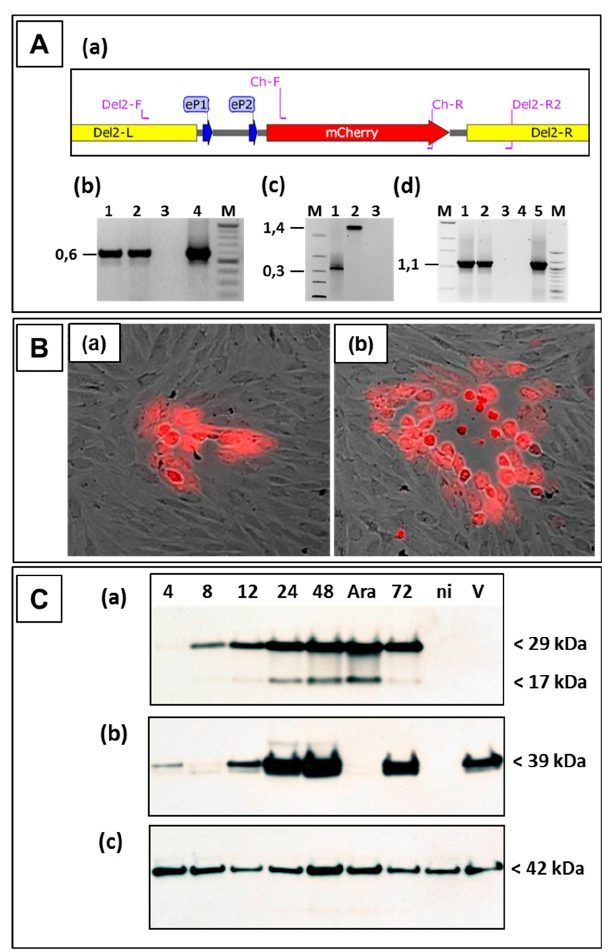
Figure 4. Legend: Characterization of the ORFV recombinant D1701-V-D12-mCherry. ( A ) PCR demonstrating correct transgene insertion. ( a ) Map section of plasmid pD12-mCherry illustrates location of the used primers also described in Table 1. The left (Del2-L) and the right (Del2-R) homology arm for recombination, early promoter eP1 and eP2 and the mCherry gene are shown. ( b ) Using primer pair Ch-FR the mCherry -specific amplicon of 0.59 kbp in size was obtained with DNA from red virus plaques (lanes 1 and 2) and with control plasmid pD12-Cherry (lane 4) but not in non-infected cells (lane 3). ( c ) Shows the result of the D locus-specific PCR Del2-FR2. Using DNA from D12-Cherry infected Vero cells (lane 2) the specific 1.4 kbp amplicon was obtained, whereas DNA from cells containing the parental D1701-V (lane 1) results in a 0.39 kbp amplicon due to the absence of gene insertion. DNA from non-infected cells (lane 3) was used as negative control. ( d ) Demonstrates the results of the PCR with the primers Del2-F and Ch-R. The specific amplicon of 1.1 kbp was obtained with DNA from D12-Cherry infected cells (lanes 1 and 2) or with plasmid pD12-mCherry (lane 5). DNA from non-infected cells (lane 3) and without template DNA (lane 4) were used as negative controls. In lanes M size marker (1 kbp ladder or 100 bp ladder, NEB) were separated. On the left the sizes are given in kbp. ( B ) Expression of mCherry allows identification of red fluorescent virus plaques of the ORFV recombinant D1701-V-D12-mCherry (D12-Cherry), which became clearly visible 12 h (a) and 24 h (b) after infection. Microscopic magnification 40 × . ( C ) Western blot analysis of Vero cells infected with the recombinant D12-Cherry. ( a ) The mCherry was detectable with a specific antiserum during 4 to 72 h after infection but not in non-infected (lane ni) or in D1701-V infected (lane V) Vero cells. In infected cells treated with AraC to arrest ORFV gene expression in the early phase mCherry expression was detectable, too. Panel ( b ) demonstrates expression of the late major envelope protein (ORF059) with monoclonal antibody 4D6 in cells infected with the recombinant as well as with parental D1701-V but not in recombinant virus cells treated with AraC or in non-infected cells. ( c ) The protein load of each sample was tested using a specific antiserum against cellular β -actin. The sizes are indicated on the